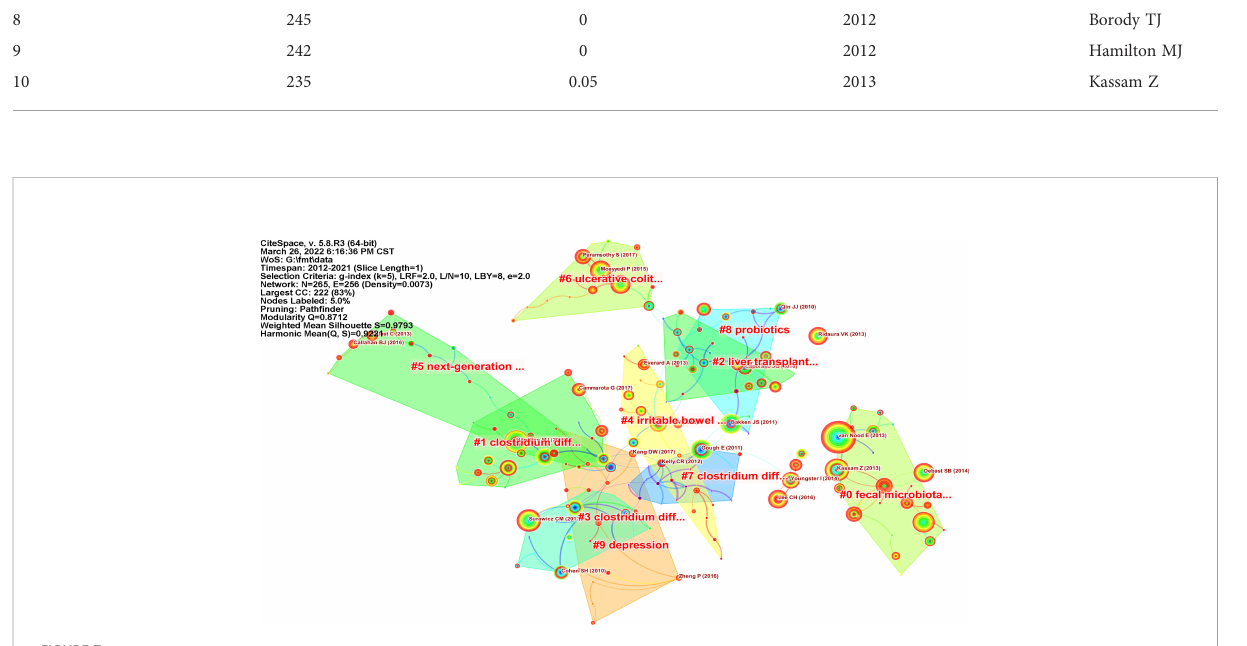
FIGURE 7 Map of co-cited references related to FMT (N=265,